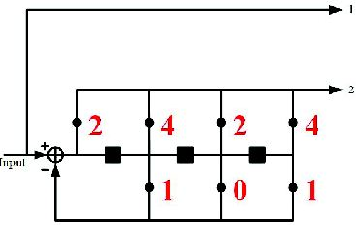
Figure 5. 3-ary, constraint length = 5,